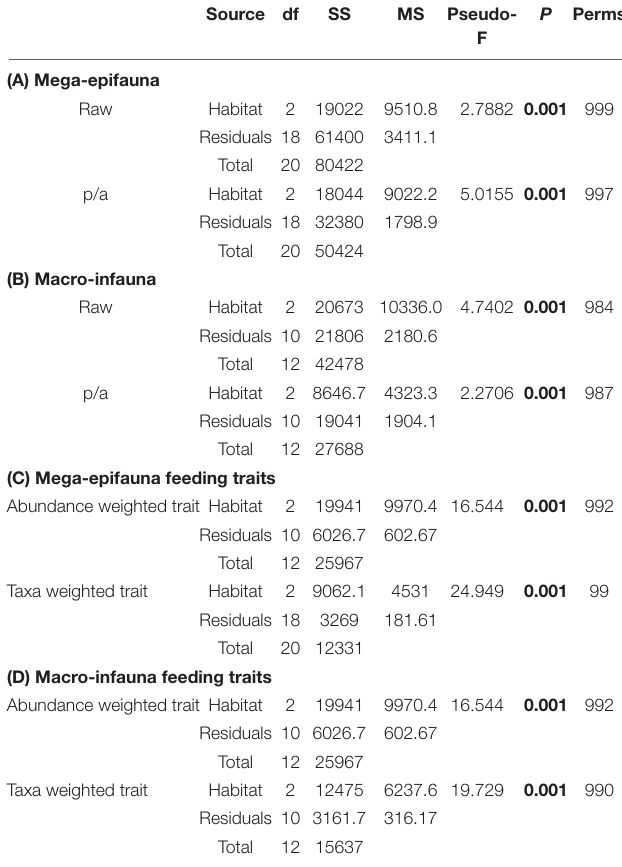
TABLE 2 | Results of PERMANOVA analyses testing for differences in benthic community composition between environments, for (A) mega-epifauna taxon identity data, (B) macro-infauna taxon identity data, (C) mega-epifauna feeding traits, and (D) macro-infauna feeding